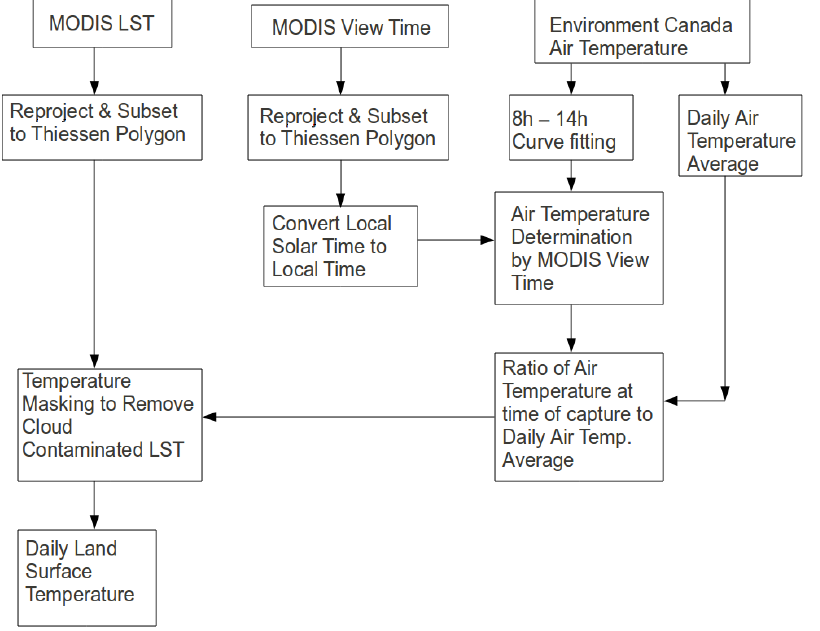
Figure 3. Mean Daily Surface Temperature (ICM) Algorithm flow diagram, describing how MODIS LST and air temperature records are combined to produce a mean daily surface